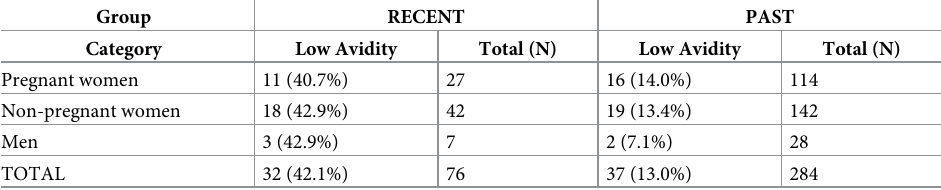
Table 2. Percentage of low IgG avidity results in the first sample in three categories of patients with recent acute toxoplasmosis and with past toxoplasmosis. Group